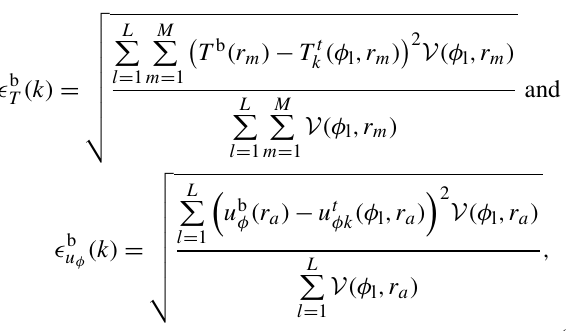
Figure 1. Time evolution of the errors in the estimated tempera- ture field (panels a to c ) and the estimated surface velocities (panels from d to f ) obtained from data assimilations with the same 150Myr observation dataset, but different assimilation parameters. The size of the ensemble is N = 96 for (a) and (d) , N = 288 for (b) and (e) and N = 768 for (c) and (f) . The assimilations are computed for any combination of data assimilation parameters: γ + = 1 . 25, (cid:96) v = 0 . 3, 0 . 5, 0 . 7 and 1 and (cid:96) h = π/ 10, π/ 8, π/ 6, π/ 4 and π/ 2. The black lines represent the evolution of the error for the assim- ilation with the minimum average error in the analyzed tempera- ture field: N = 96, (cid:96) z = 0 . 5, (cid:96) h = π/ 6 and γ + = 1 . 25 for (a) and (d) , N = 288, (cid:96) z = 0 . 7, (cid:96) h = π/ 10 and γ + = 1 . 25 for (b) and (e) , N = 768, (cid:96) z = 0 . 5, (cid:96) h = π/ 4 and γ + = 1 . 25 for (c) and (f) . The gray area is delimited by the maximum and minimum values of er- rors at each time, for all data assimilations. The background error is represented in red for